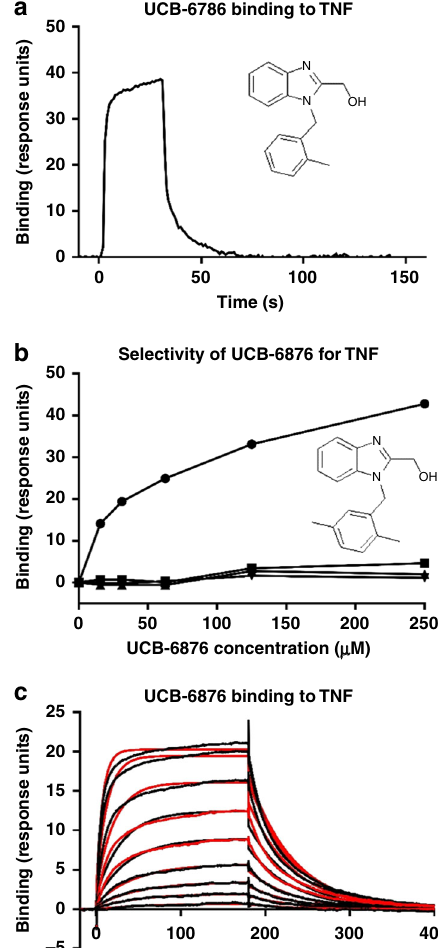
Fig. 1 Fragments bind to TNF with slow-binding kinetics. a SPR depicts the binding of UCB- 6786 to immobilised TNF. b The analogue, UCB- 6876 , speci fi cally binds to immobilised TNF (solid black circles) but not to control proteins, capture antibody plus TNFR1 (solid black squares), capture antibody (solid black triangle pointed down) or TNFR1 (solid black triangle pointed up). c Kinetic analysis of UCB- 6876 using the Biacore T100 showing slow association and dissociation